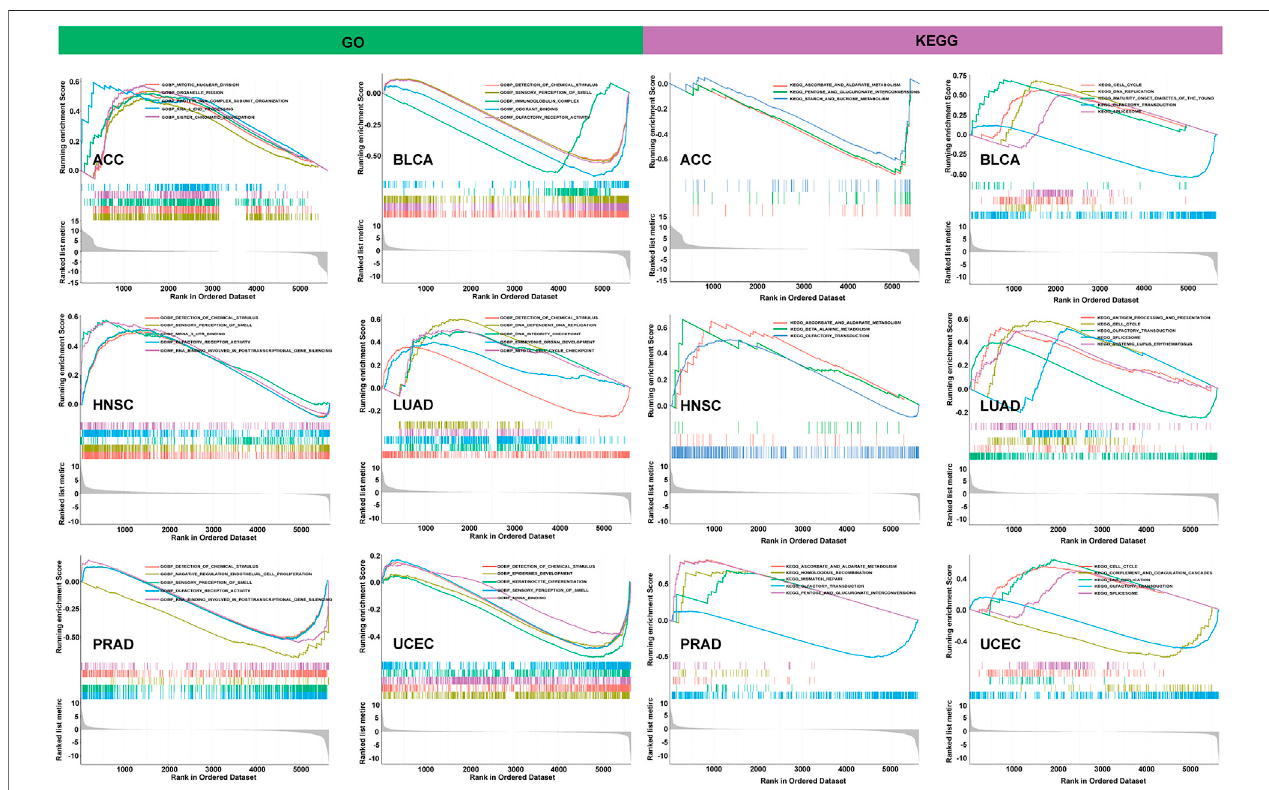
FIGURE 10 | | GO term and KEGG pathway enrichment plots from GSEA